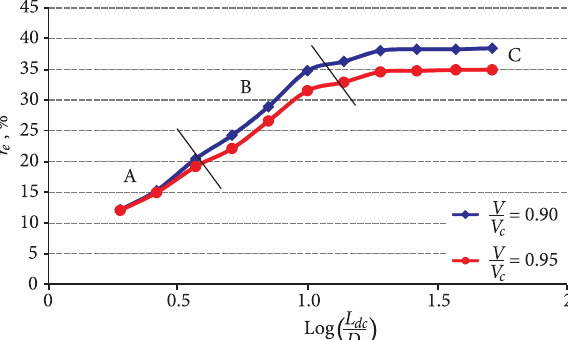
Fig. 5. Reduction percentage of scour depth with non-dimensional length in the upstream